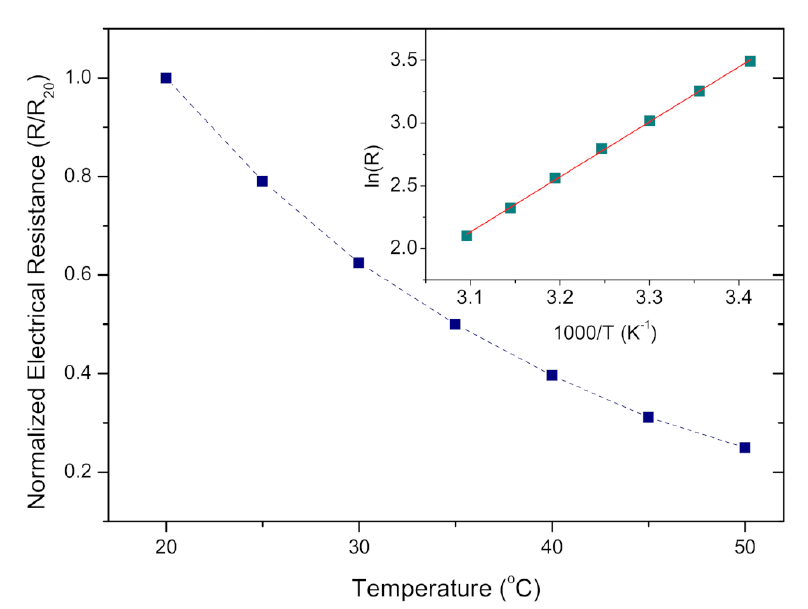
Figure 5. Electrical resistance of NiMn 2 O 4 nanocrystalline fibers; inset represents an estimation of the material constant